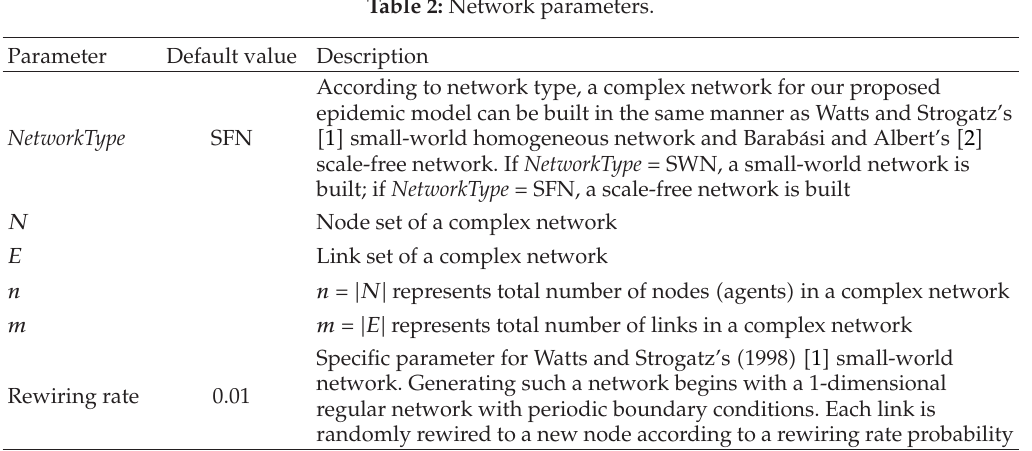
Table 2: Network